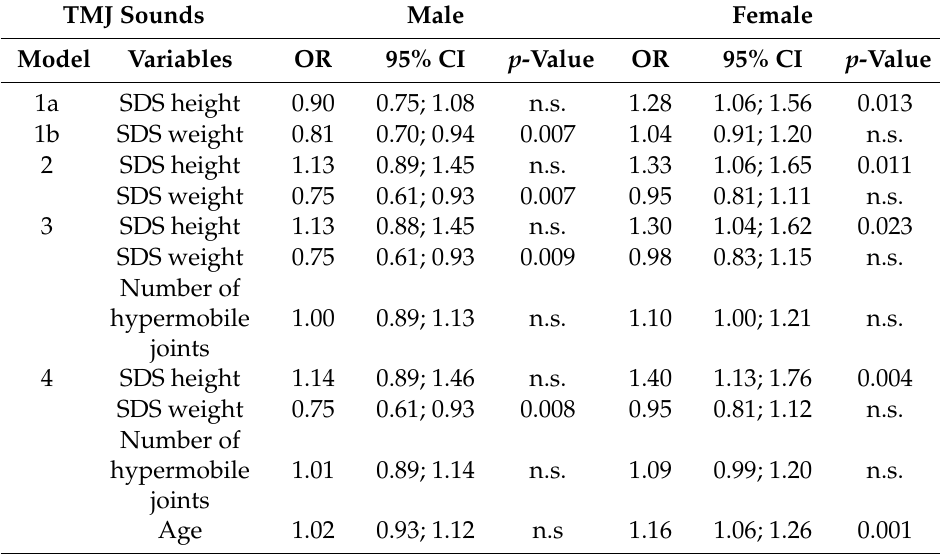
Table 3. Multivariable analyses of TMJ sounds (N = 322) in relation to physical variables; SDS: standard deviation scores, OR: odds ratio, CI: confidence interval, n.s.: not significant.